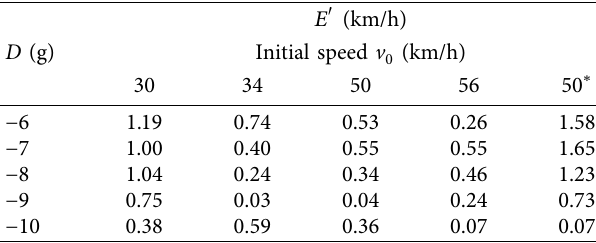
Table 23: Errors in the speed changes obtained using the ACN algorithm with